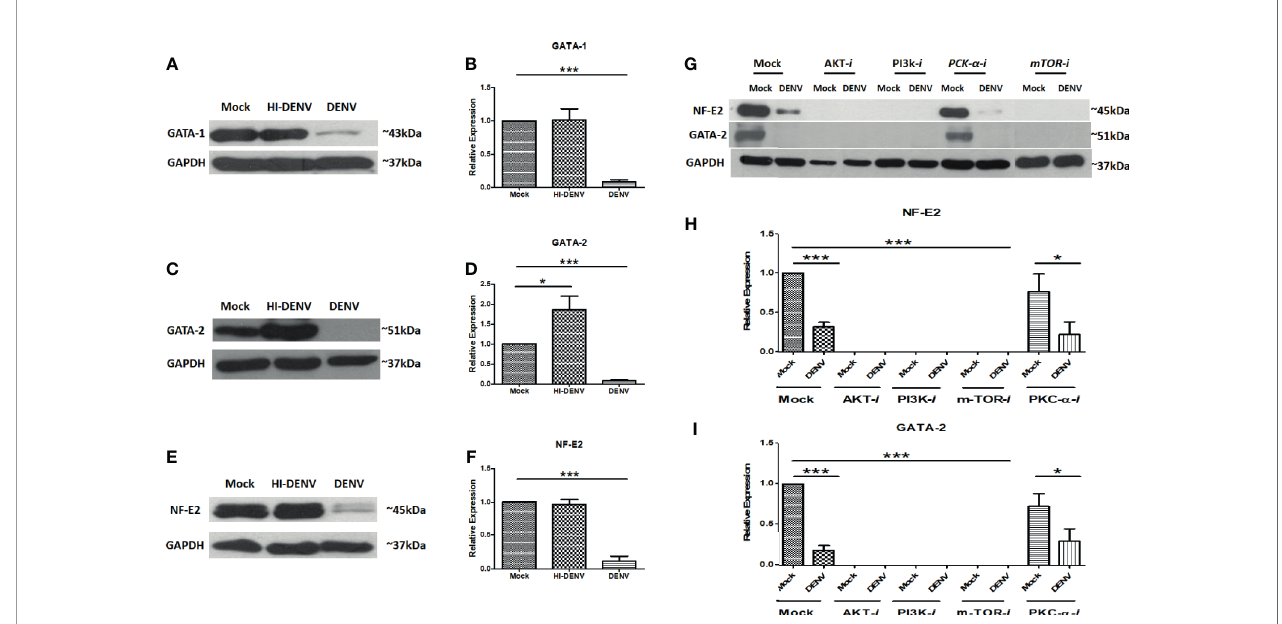
FIGURE 5 | Immunoblotting of development and maturation-speci fi c transcription factors in MEG-01 cells. Immunoblot and graphical representation of the expression of GATA-1 (A, B) , GATA-2 (C, D) , and NF-E2 (E, F) in mock, DENV inactivated virus treated, and DENV infected MEG-01 cell lysate. Effect of different inhibitors of AKT (AKT-IV), PI3K (Ly294002), mTOR (Torin-1), and PKC a (HBBDE) on the expression of most affected transcription factors (G) and their graphical presentation (H, I) during DENV infection. (*pValue < 0.05; ***pvalue <